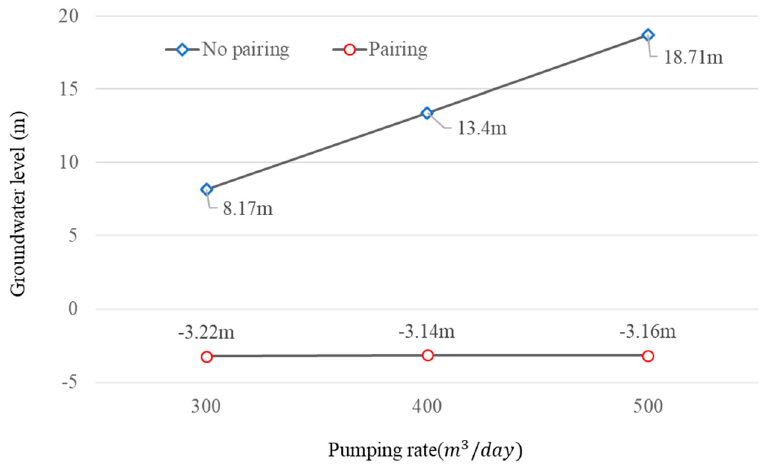
Figure 12. Groundwater level at the injection well in the presence or absence of the pairing system (hydraulic conductivity: 2 × 10 − 7 m/s; pumping rate: 500 m 3 /d).